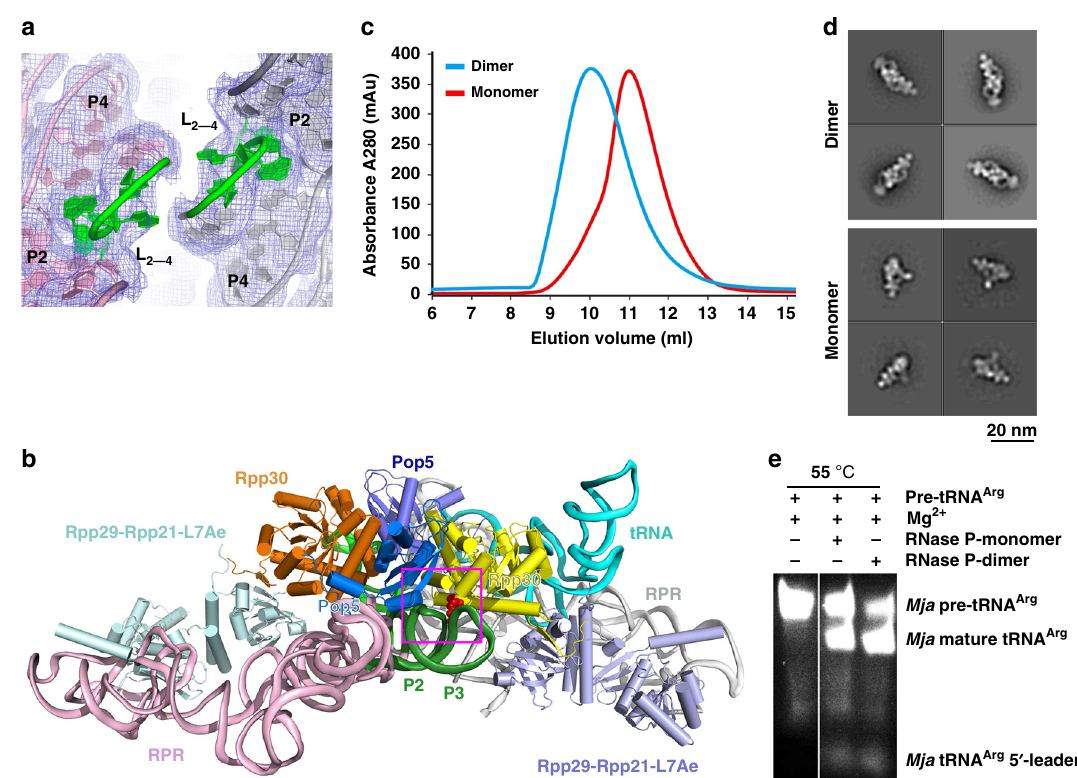
Fig. 8 Dimeric organization of Mja RNase P. a The loops between stems P2 and P4 from the two RPRs staggered pack together. The two loops are colored in green and the two RPRs in pink and gray, respectively. The EM density map is shown in light blue mesh. b Overall view of the dimeric conformation mediated by the (Pop5-Rpp30) 2 heterotetramer. Rpp30 simultaneously interacts with the two RPR molecules in the dimeric holoenzyme. c SEC pro fi les of the WT (Dimer, blue) and mutant (Monomer, red) Mja RNase P complexes. d Selected 2D class averages of the WT (Dimer, top) and mutant (Monomer, bottom) Mja RNase P complexes. e In vitro tRNA processing assay of WT (Dimer) and mutant (Monomer) Mja RNase P complexes